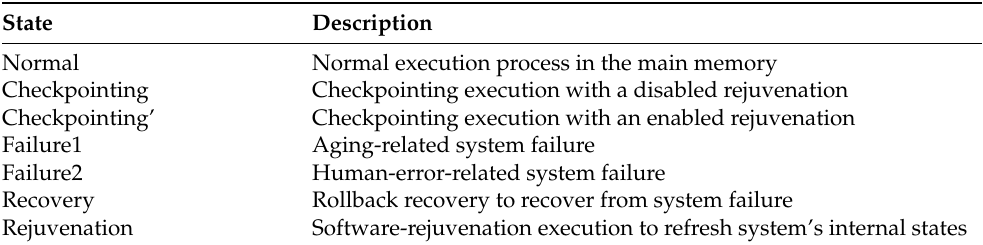
Figure 4. Non-Markovian state-transition diagram. Table 3. State notation in non-Markovian state-transition diagram.